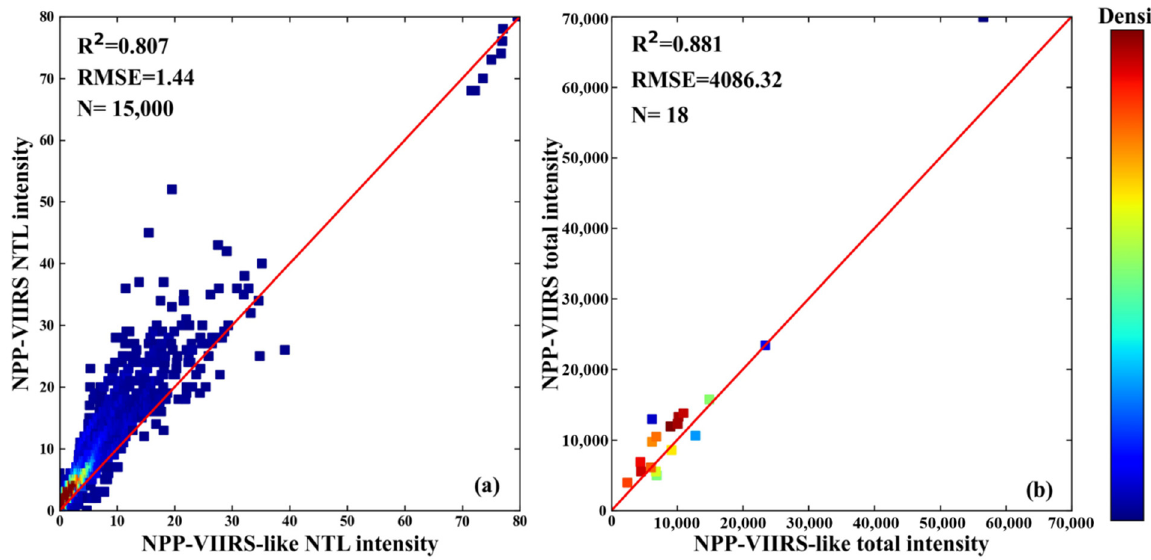
Figure 2. The comparison with density between 2012 for the composited NPP-VIIRS NTL data and extended NPP-VIIRS-like NTL data in Henan: ( a ) the pixel-level and ( b ) the city-level. The solid line denotes the 1 : 1 line, and N is the number of sample points (cities).